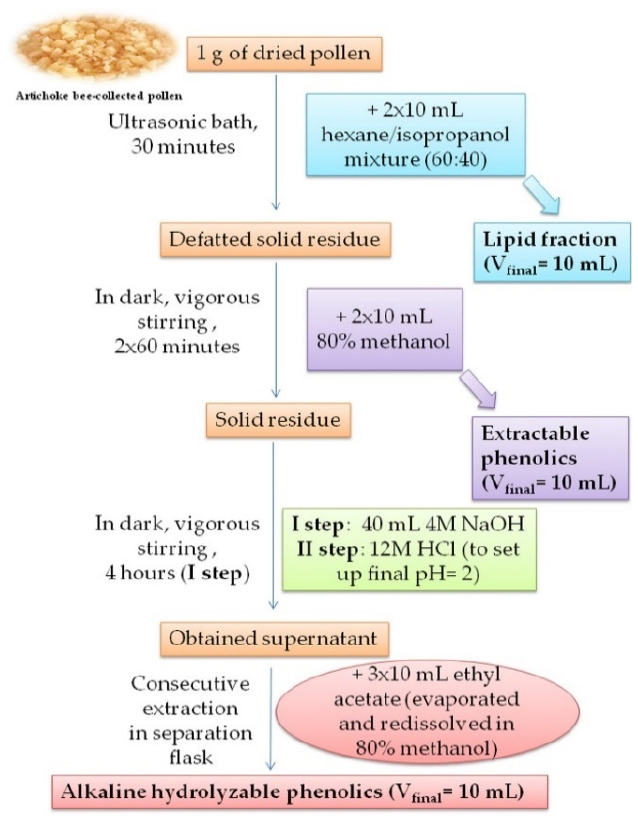
Figure 1. The sheme of extraction procedure.